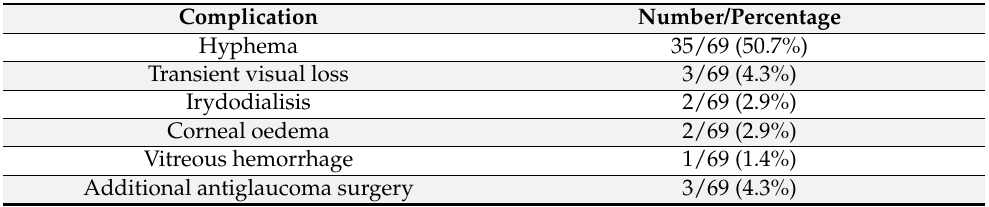
Table 4. Complications observed after GATT